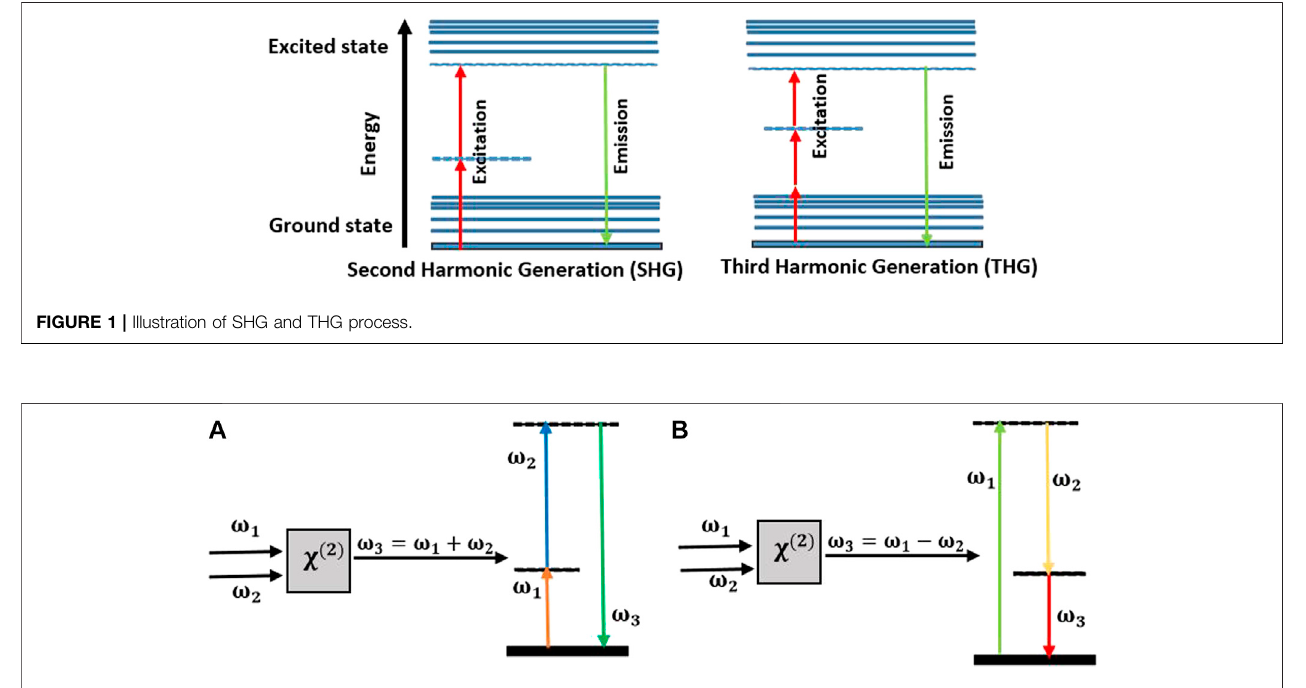
FIGURE 2 | Illustration of (A) SFG and (B) DFG